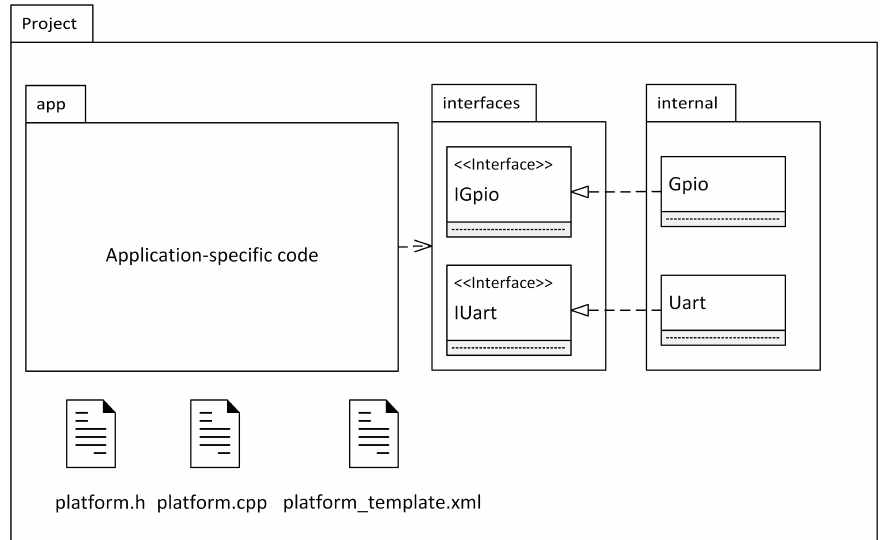
Figure 13. Overview of the source code artifacts involved with the generation process of the PinConfig tool (UML 2.5 notation with additional non-UML symbols for representing files at the bottom). The configuration generated from the PinConfig tool is located in the files